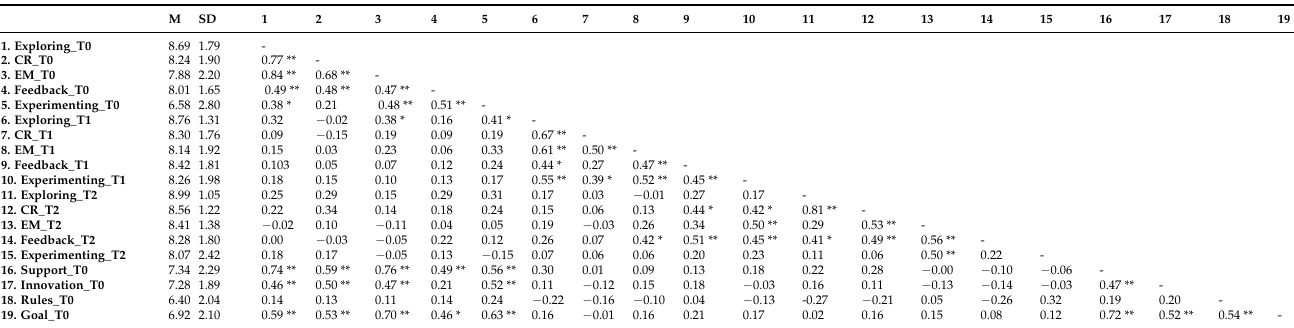
Table 1. Means, standard deviations, and correlations between study